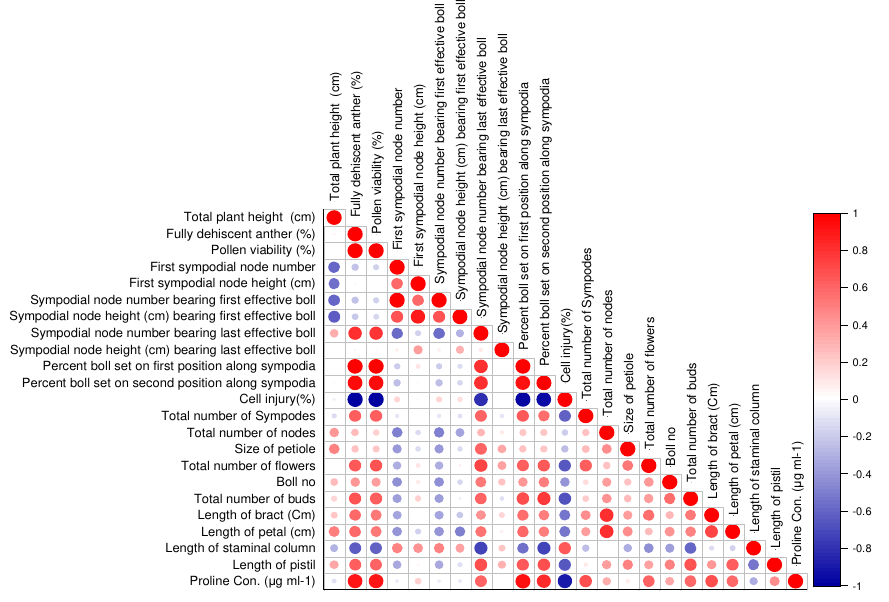
Figure 3. Pearson correlation among phenotypic traits of cotton under heat stress (= + ve = - ve).